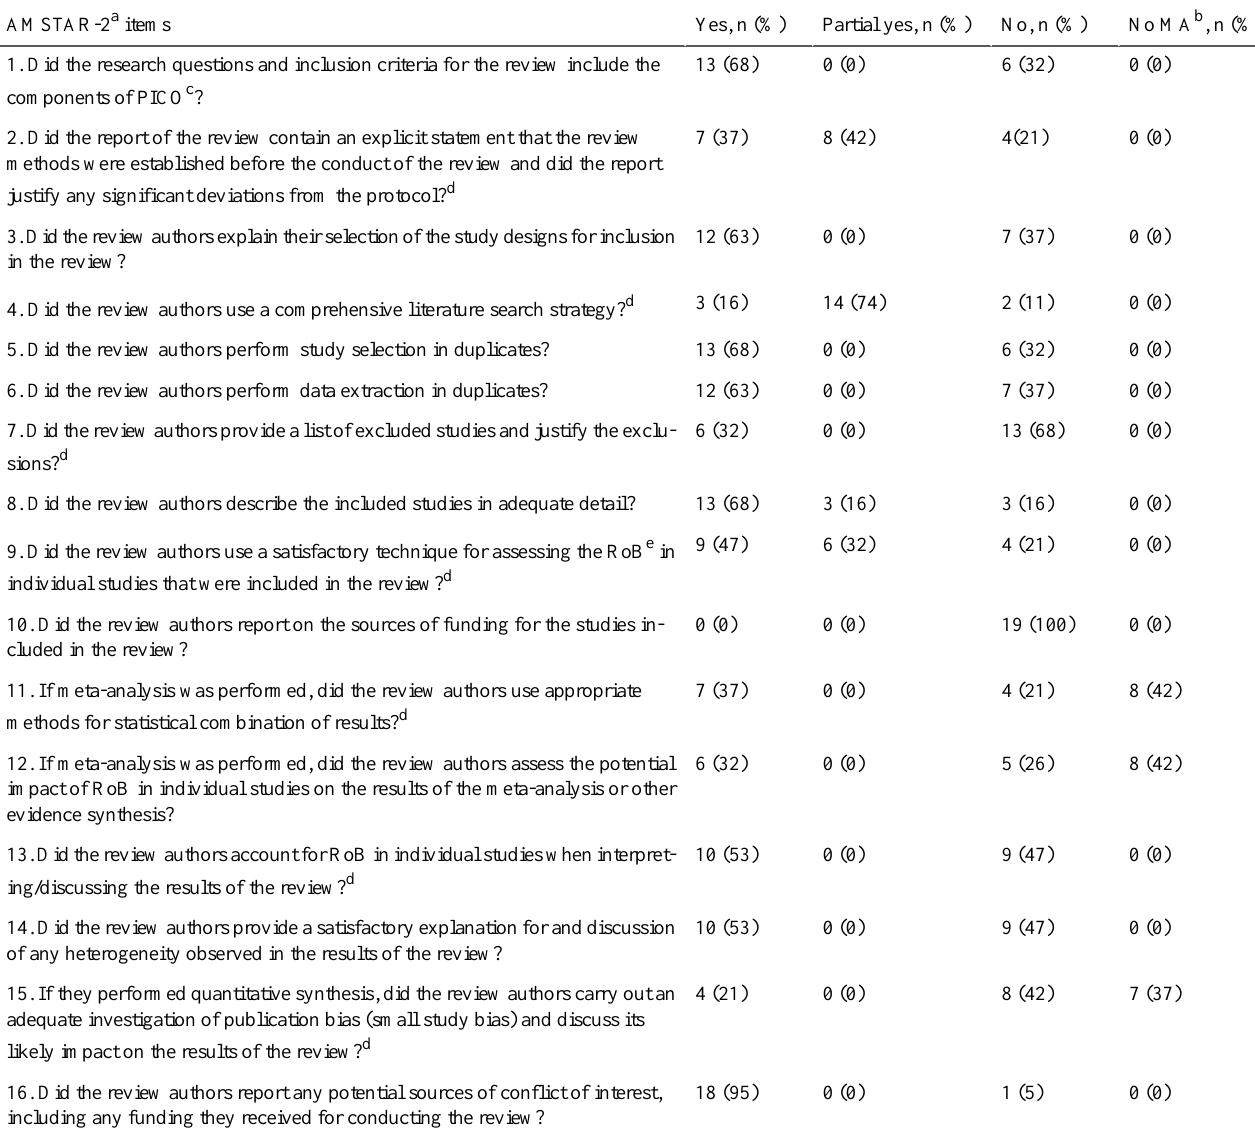
Table 3. Overall confidence assessment (Assessing the Methodological Quality of Systematic Reviews 2 tool) of the 19 included systematic